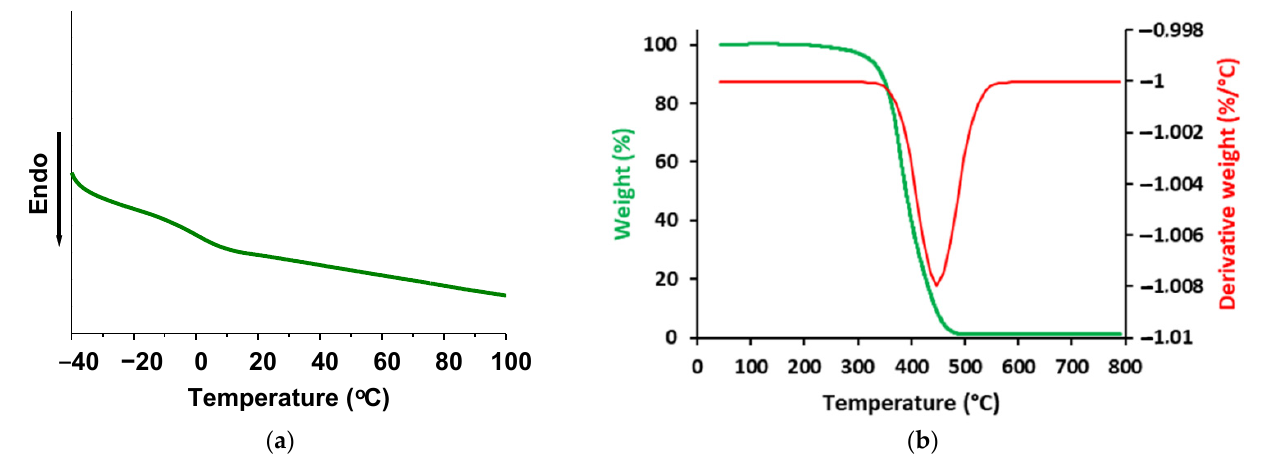
Figure 5. DSC curve ( a ) and thermogravimetric curves ( b ) of polymer 3TPOL .